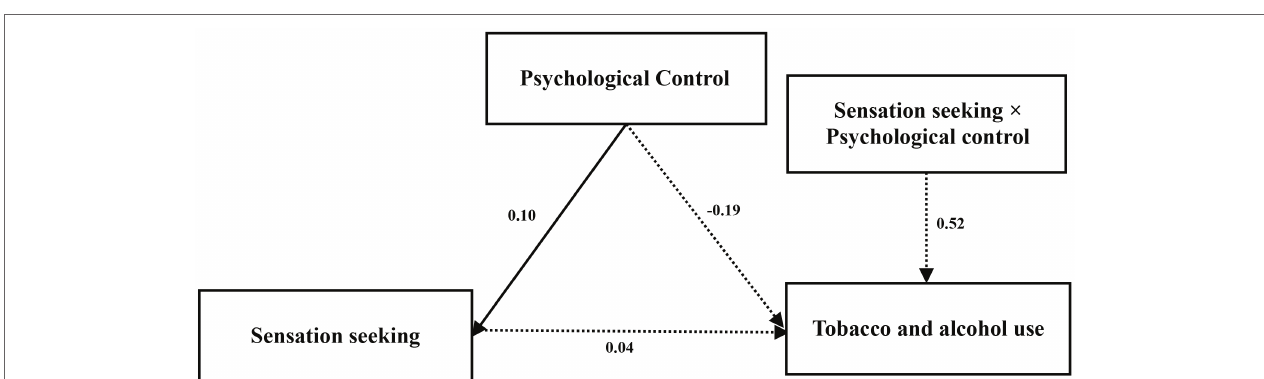
FIGURE 3 | Unconstrained model of rural area.